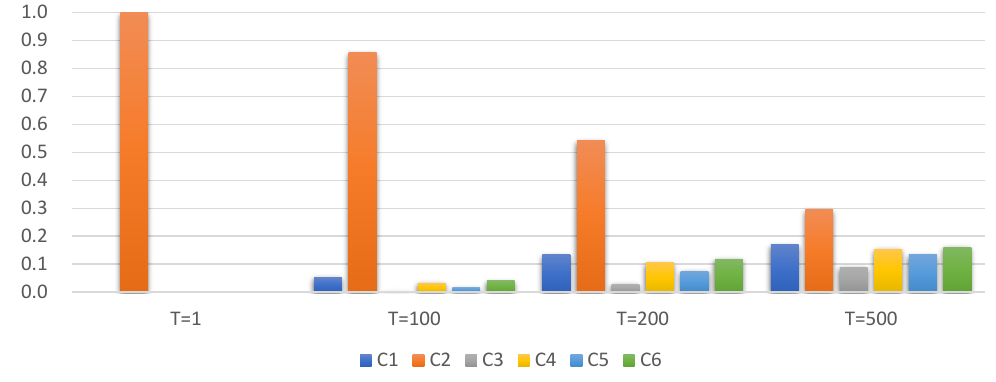
Figure 1. An example of categorical probability distributions of high-temperature softmax output with different temperature. C1 ∼ C6 denote six categories. The input logit data are listed in the last row of Table 1. When T = 1 (normal softmax), the probability of C2 tends to 1 and others tend to 0. If T goes higher, the categorical distribution tends to be more